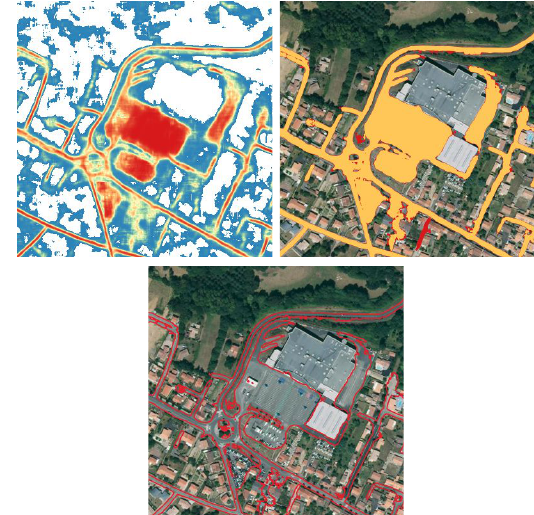
Figure 14. Vectorization of asphalt class, from left to right and top to bottom: heat map from predictions, comparison of 2 double-threshold processes (yellow and red),